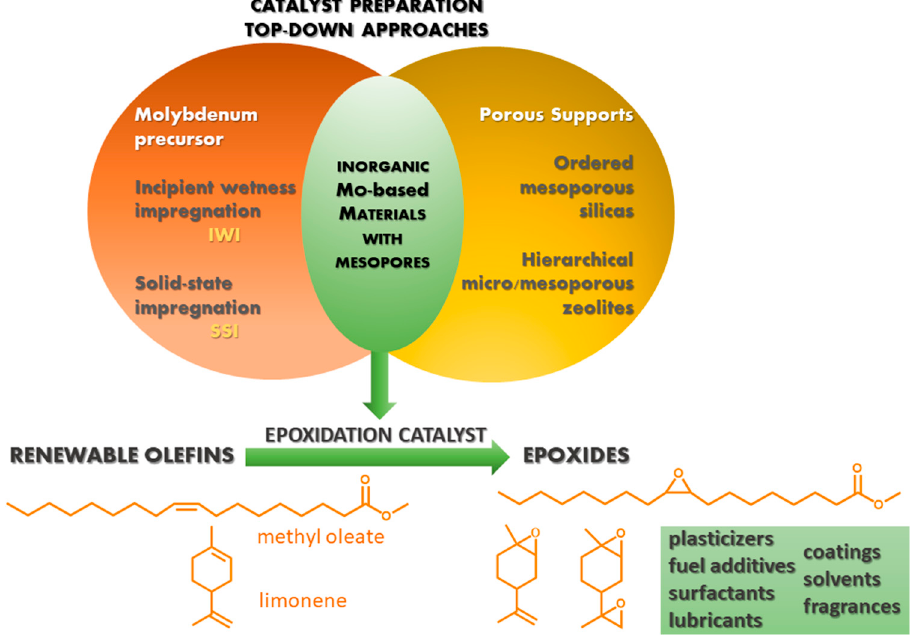
Figure 1. Chemical valorization of olefins to epoxides using fully inorganic silicate catalysts possessing mesoporosity, prepared via top-down strategies.